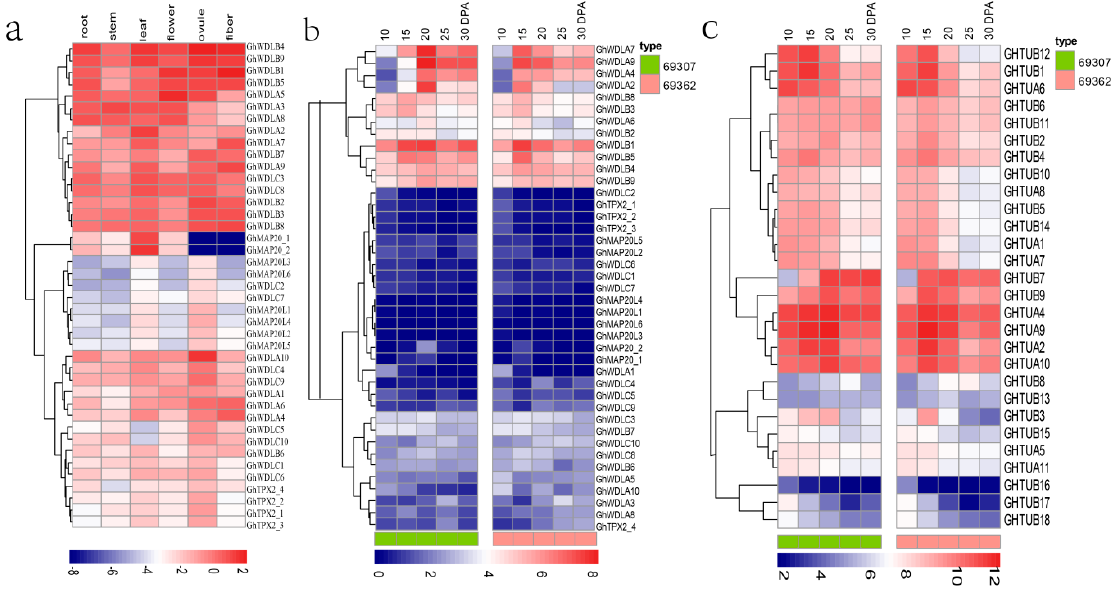
Figure 5. Expression analysis of TPX2 genes in G. hirsutum : ( a ) heatmap showing the expression levels of GhTPX2 genes in different tissues: ( b ) heatmap presenting the expression levels of GhTPX2 genes, and ( c ) heatmap presenting the expression levels of Ghtubulin genes.